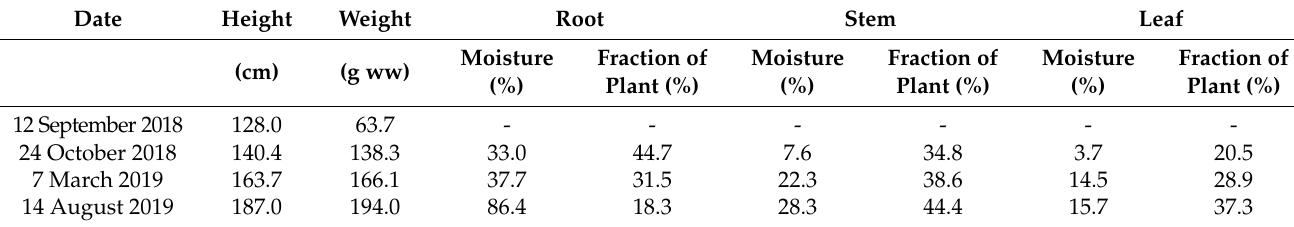
Table 3. Characteristics of Samples at Harvest Time. Each Sample Was Constituted by a Pool of Plants. Height Was Expressed as the Average Height of the Reed Grass Belonging to the Same Pool. The Percentage of Moisture Was Estimated in the IRSA-CNR Laboratory (see Section 2.5). The Reed Grass Collected on 12 September (Percentage of Moisture = 49.9%) Was Not Divided into Fractions Because Its Leaves Were Not Yet Unfurled.